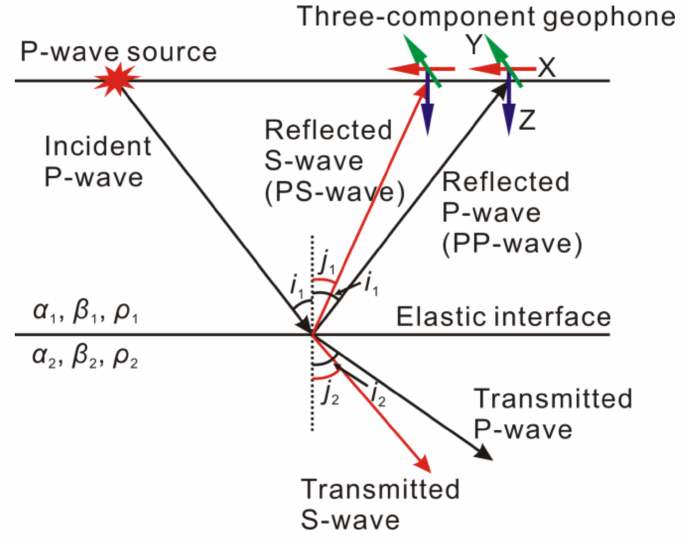
Figure 1. Schematic diagram of the reflected and transmitted waves when a P-wave is incident upon an underground elastic